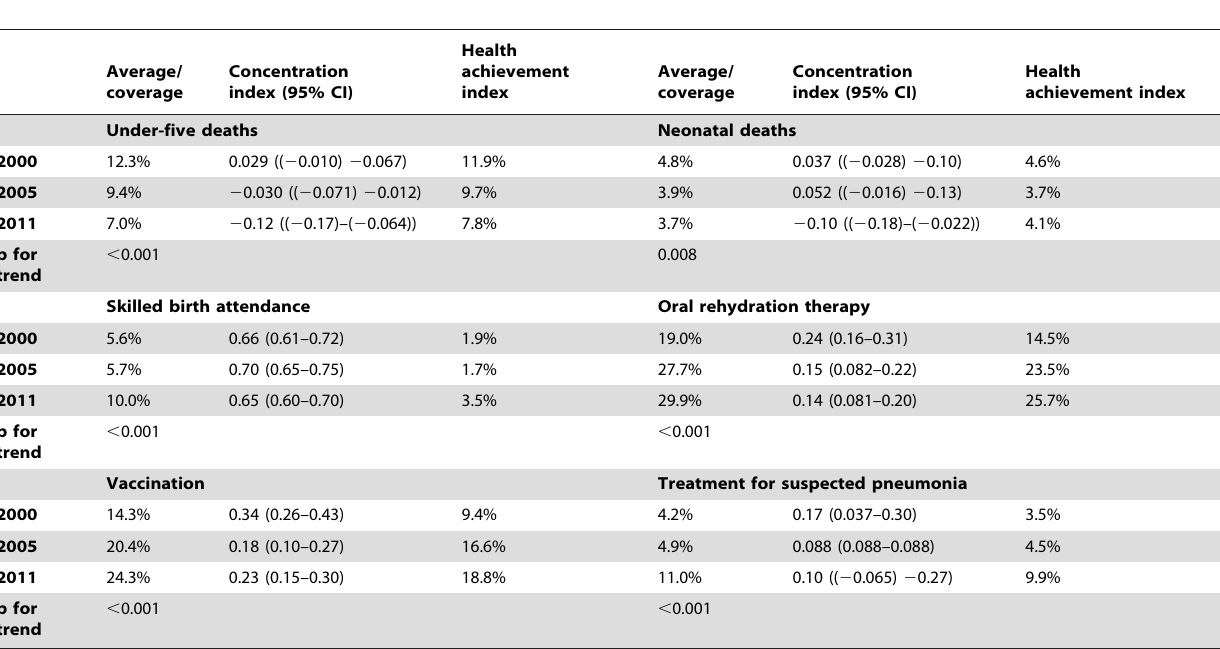
Table 3. Change in average level and health achievement index from 2000 to